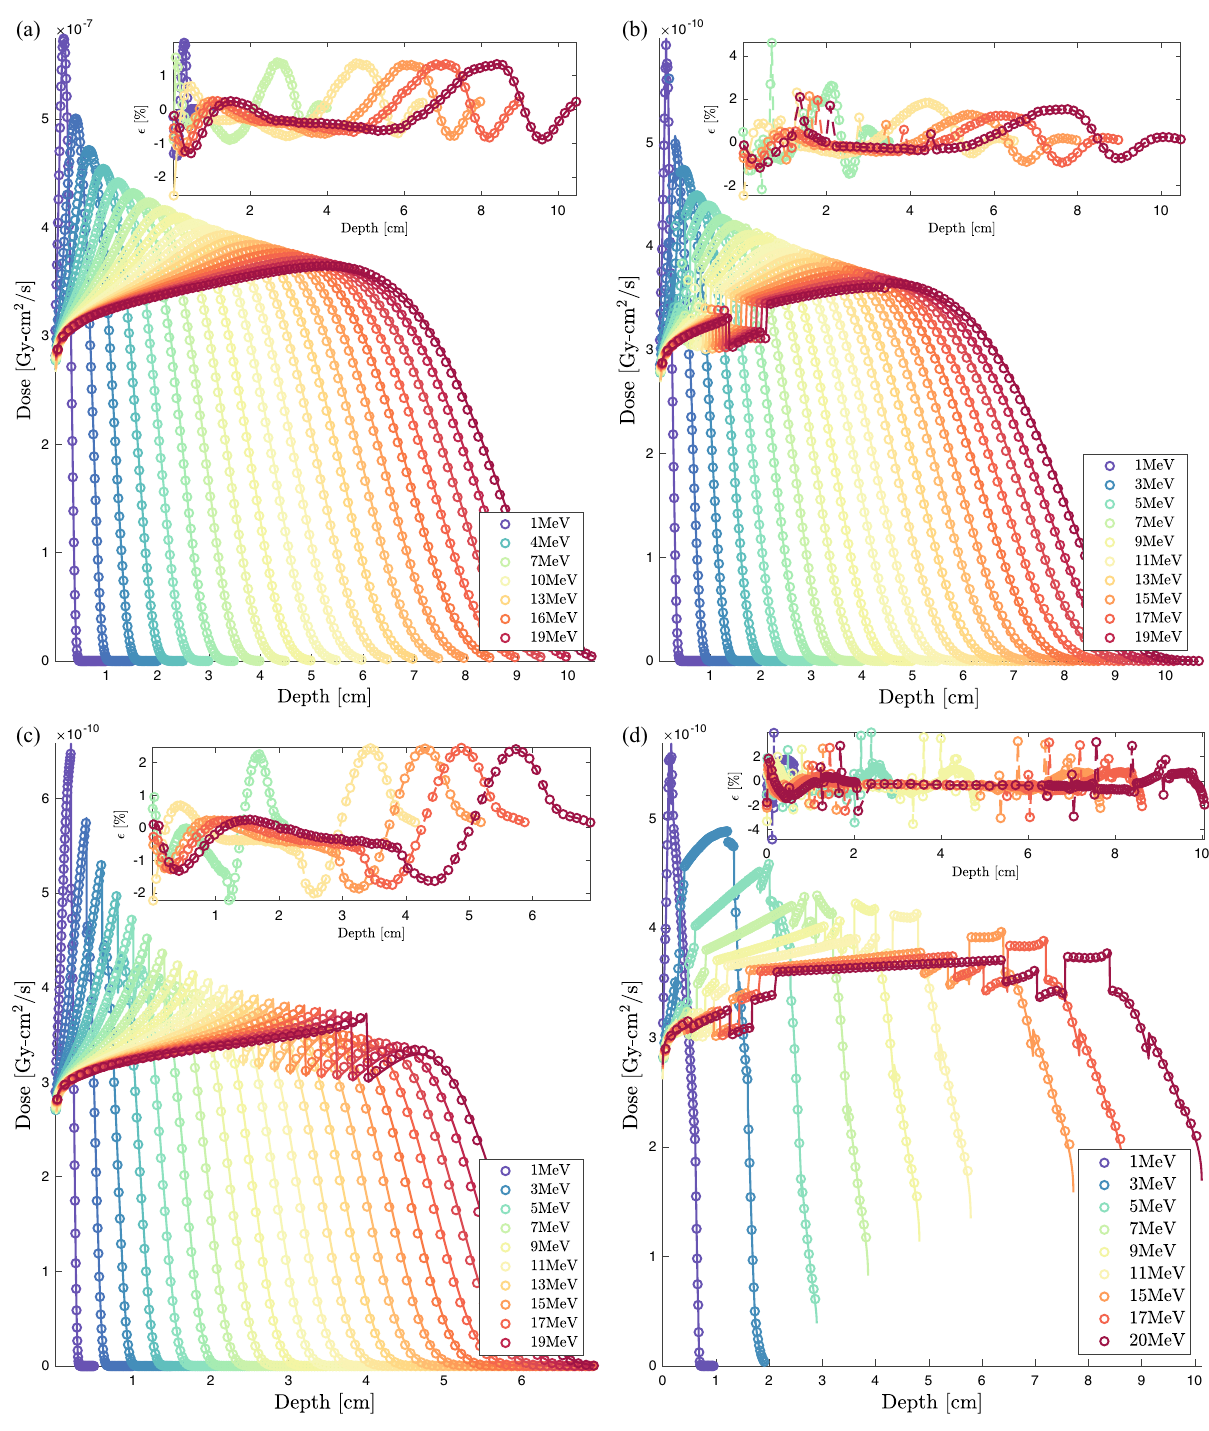
Figure 2. NJOY-Dragon-5 depth-dose curves ( solid lines ) compared to Geant-4 ( circles ) for 1 to 20MeV unidirectional electron beams incident on: ( a ) water benchmark; ( b ) thorax benchmark; ( c ) IORT-benchmark and ( d ) high-heterogeneity benchmark. Insert shows Dragon-5 relative error with respect to Geant-4. Normalization of any relative error presented is made with respect to the maximum dose observed for the incident beam. Monte Carlo convergences are obtained for a 0.2% mean standard